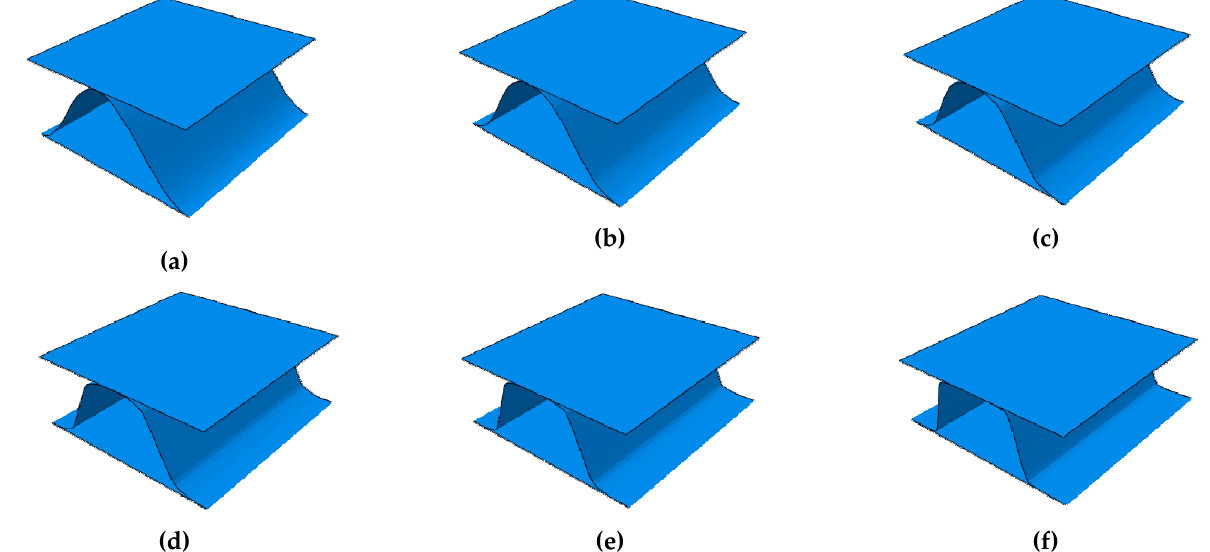
Figure 7. The crushed geometries of the corrugated cardboard obtained from the static finite element analysis: ( a ) 0%, ( b ) 10% , ( c ) 20% , ( d ) 30% , ( e ) 40% and ( f ) 50% .